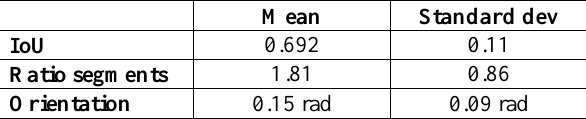
Table 2. Regularization performance